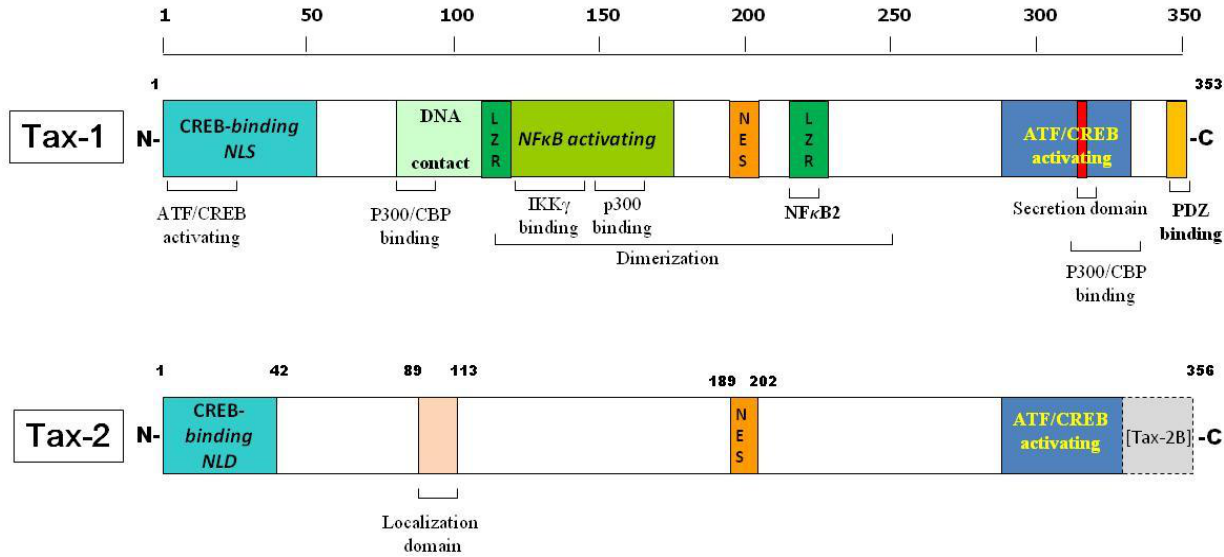
Figure 1. Structural and functional domains of Tax-1 and Tax-2. Specific domains, and the regions involved in transcriptional activation pathways are